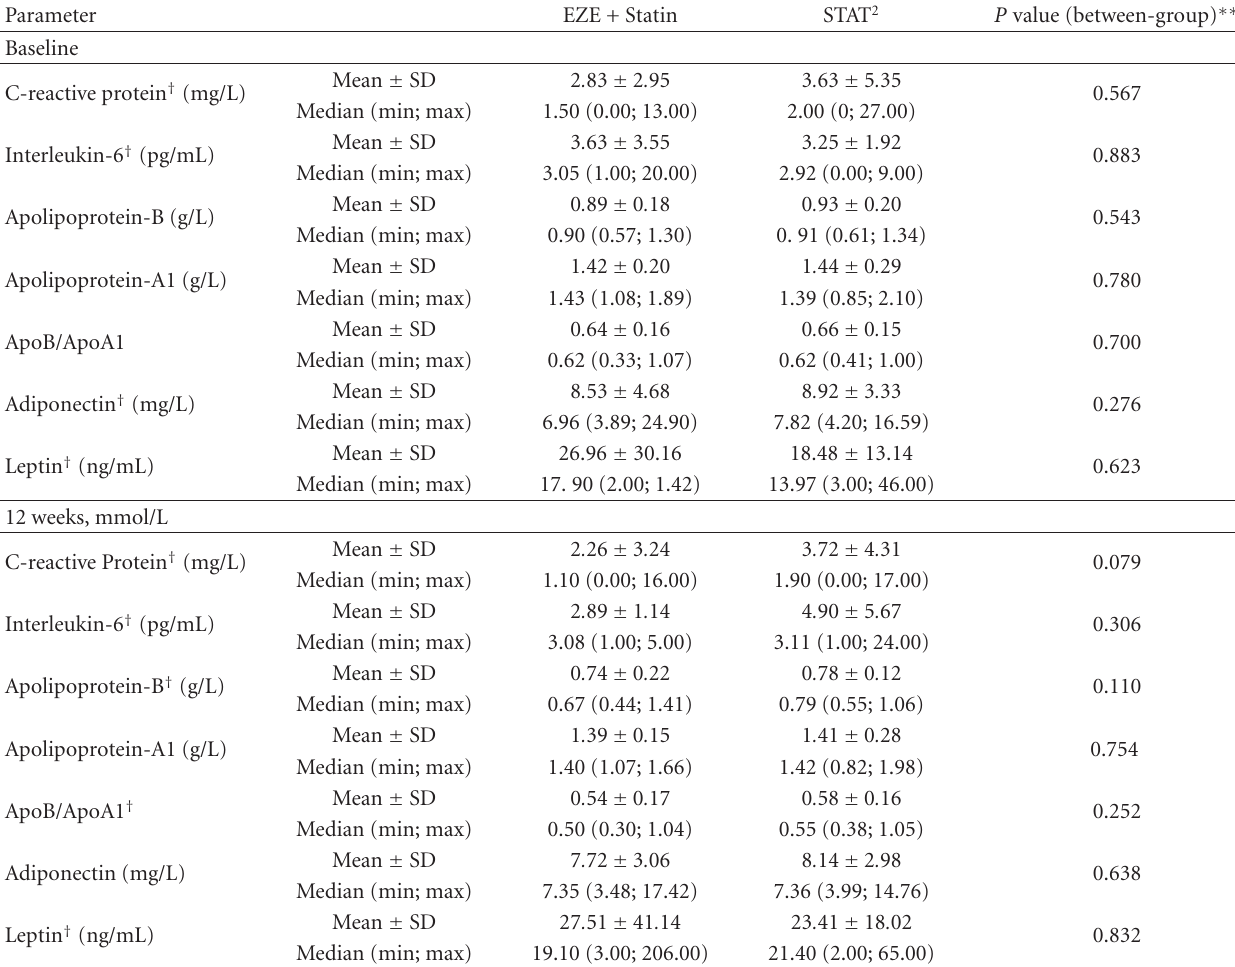
Table 5: Exploratory markers ∗